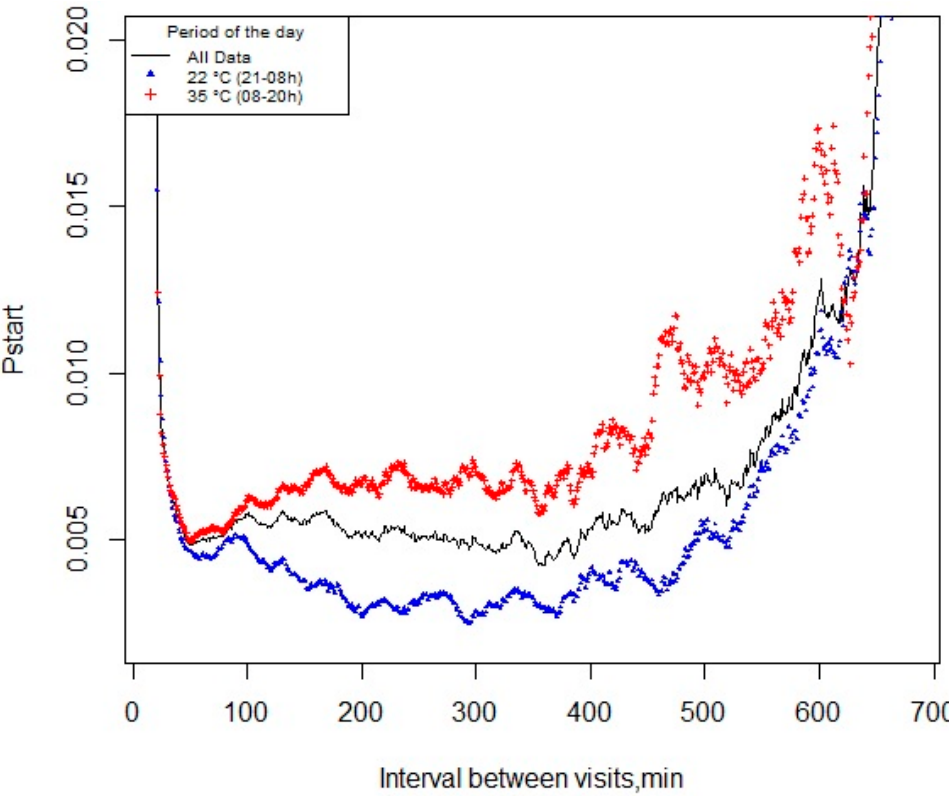
Figure 2. Probability of pigs starting a new feeding event ( p start) within the next minute since the last visit over the course of the day, or during exposure to cyclic high ambient temperature (35 °C, 0800–2000 h) or thermoneutrality (22 °C, 2000–0800 h).